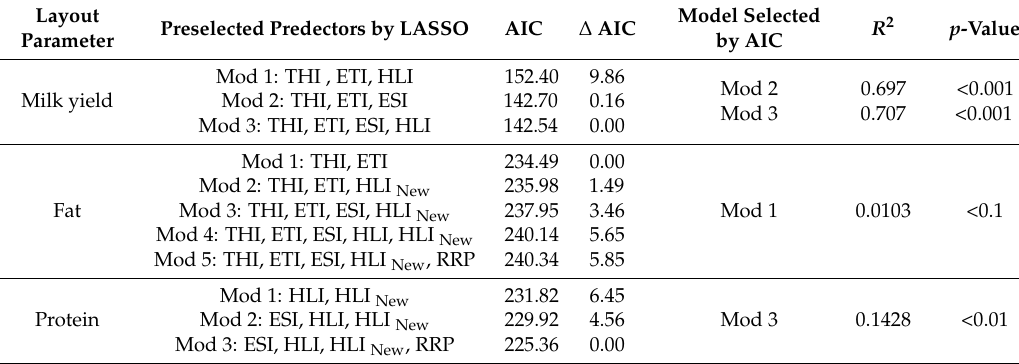
Table 6. Results of LASSO and AIC analysis for finding the best multiple regression model between milk parameters and climatic indices in